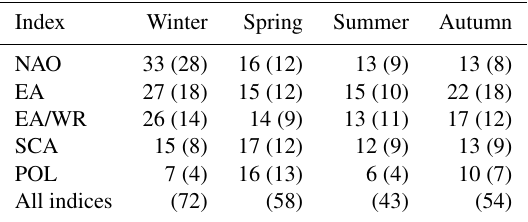
Table 2. Same as Table 1 but for monthly covariates at the same month as the seasonal streamflow